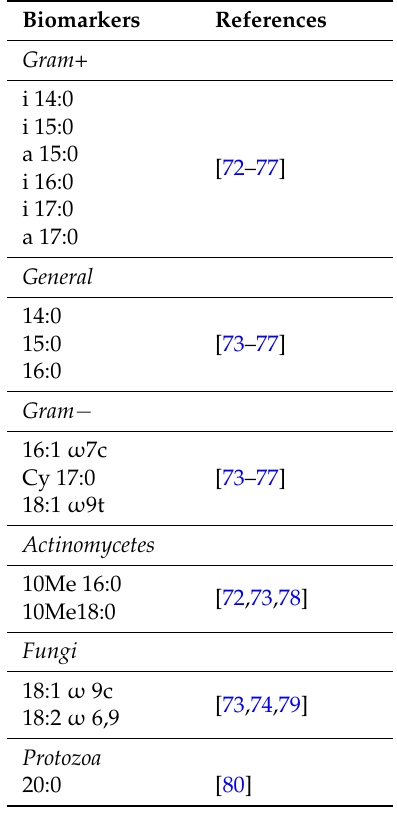
Table A4. Correlations table between the fluxes (SR and A net ) with the climatic variables and the plant water status in the two sites. Bold values are significant at p <